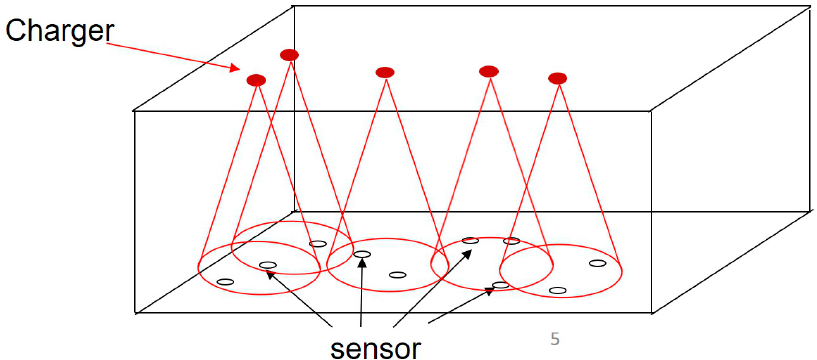
Figure 1. The chargers were deployed on the